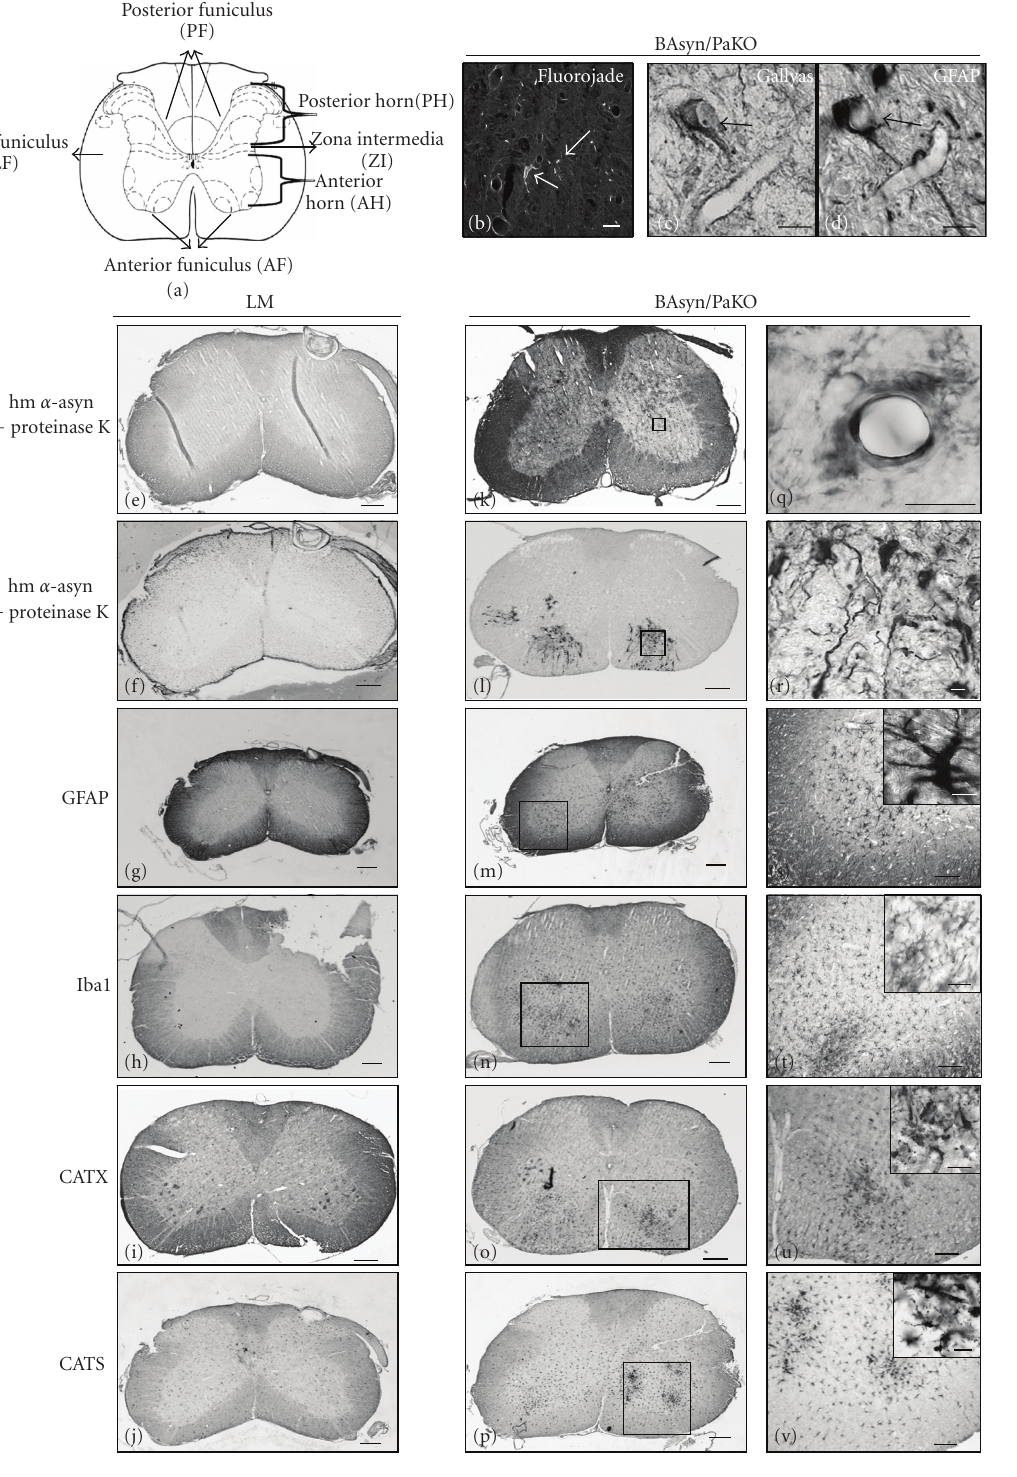
Figure 2: Immunohistochemical analyzes and cell death staining of the cervical spinal cord . Schematic illustration of the transversal spinal cord (a). Cell death staining by FluoroJade and Gallyas are shown in (b) and (c) for BAsyn/PaKO. An example showed a cell positive for Gallyas and GFAP in adjacent slices ((c), (d)). Immunopositive structures of the cervical spinal cord for hm α -syn (with or without proteinase K), GFAP, Iba1, CATX, and CATS are shown for LM in (e)–(j) and for BAsyn/PaKO in (k)–(p). (q)–(v) are higher magnifications of (k)–(p). Scale bars: (e)–(p): 200 μ m; (q) and (r): 10 μ m, (s)–(v): 100 μ m, and details of (s)–(v): 10 μ